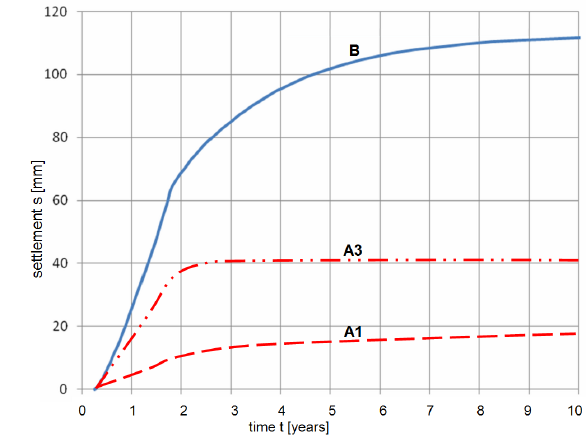
Figure 5: Consolidation analysis for the main calculation variants: A1, A3 - minimum and maximum settlement curves determined according to original design data, B - settlement curve determined for the additional geotechnical investigations.